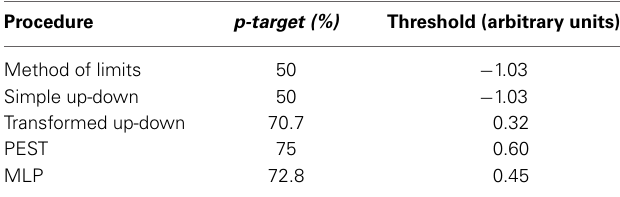
Table A1| p-targets and corresponding thresholds of the virtual listener used in the